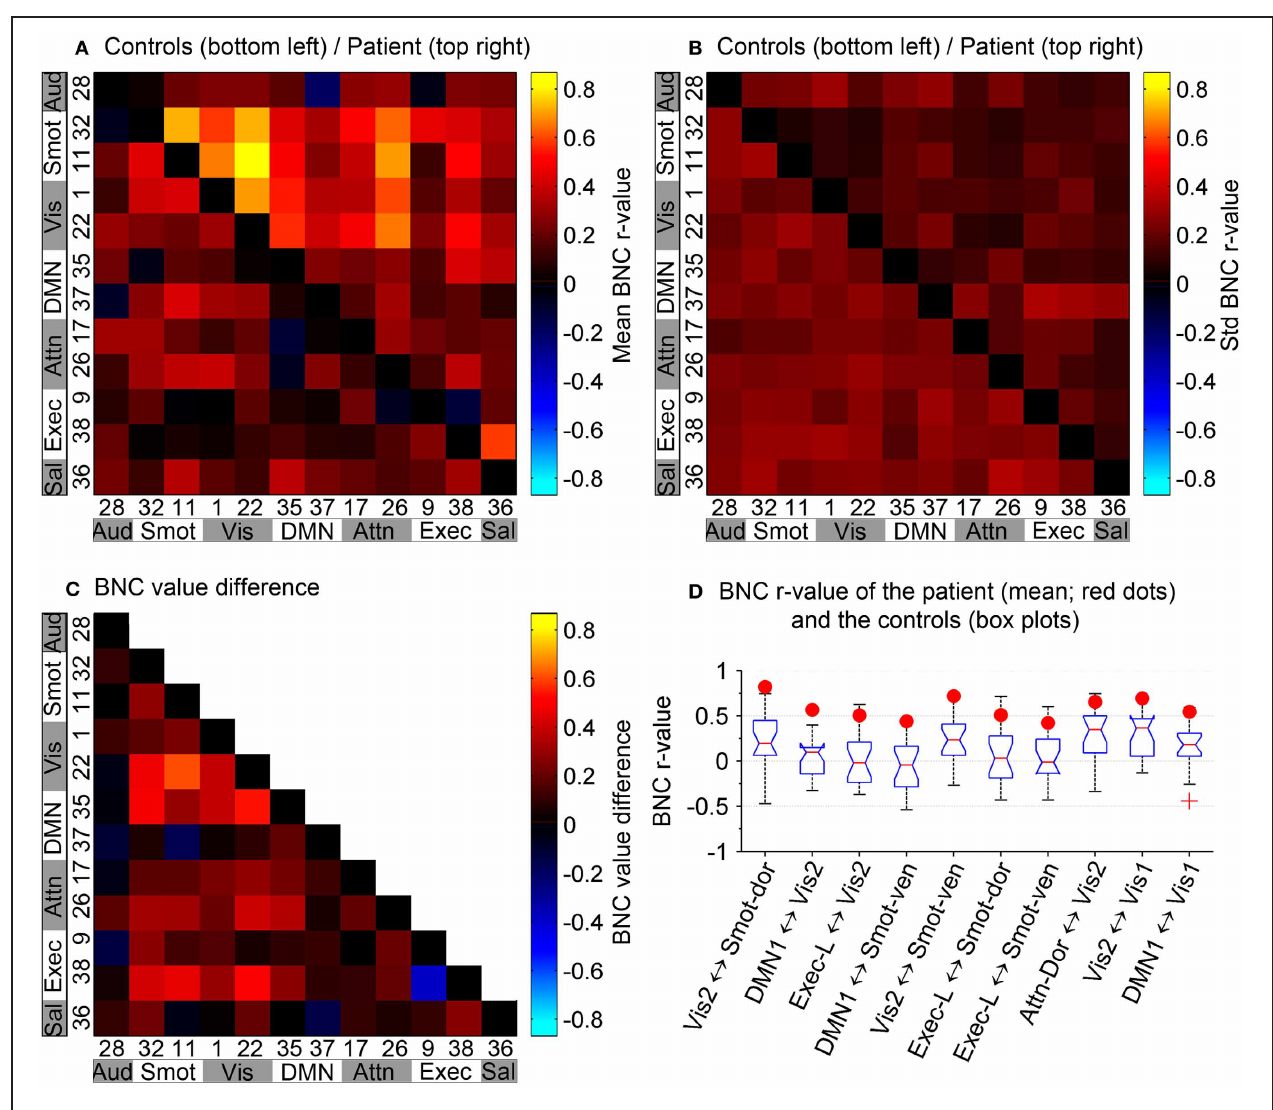
FIGURE 6 | Between-network connectivity. (A) BNC correlation matrix shows synchrony between pairs of functional networks. (B) Combined matrix of the standard deviation of the corresponding BNC measurements. (A,B) In reference to the top–left to bottom–right diagonal axis, bottom–left portion corresponds to the controls and top–right portion corresponds to the patient.